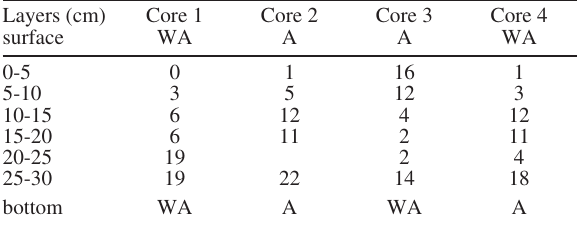
Table 2. – Geotaxis and oxygen tension responses of Polygordius eschaturus , as number of worms in the different sediment layers at the four experimental corers . WA, without aeration; A,